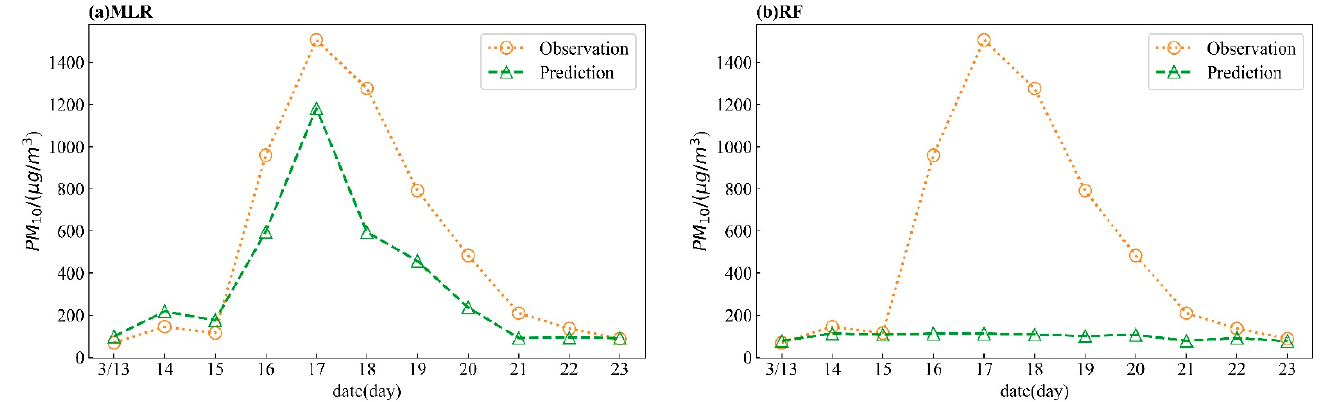
Figure 11. Comparison between predicted and observed daily mean values of PM 10 concentration in Xining City from 13 to 23 March 2021 ( a ): Multiple Linear Regression, ( b ): Random Forecast.